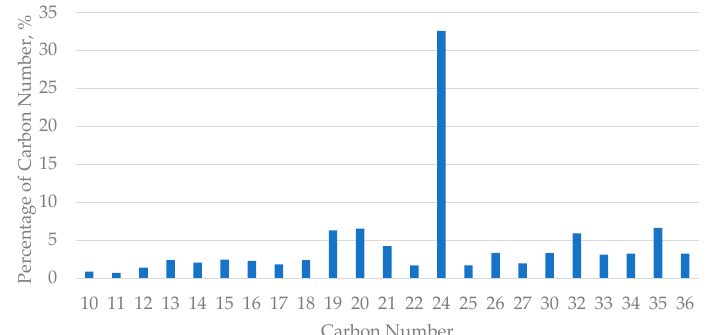
Figure 1. Percentage of the number of carbons present in crude oil wax sourced from PETRONAS, Kerteh, Malaysia.